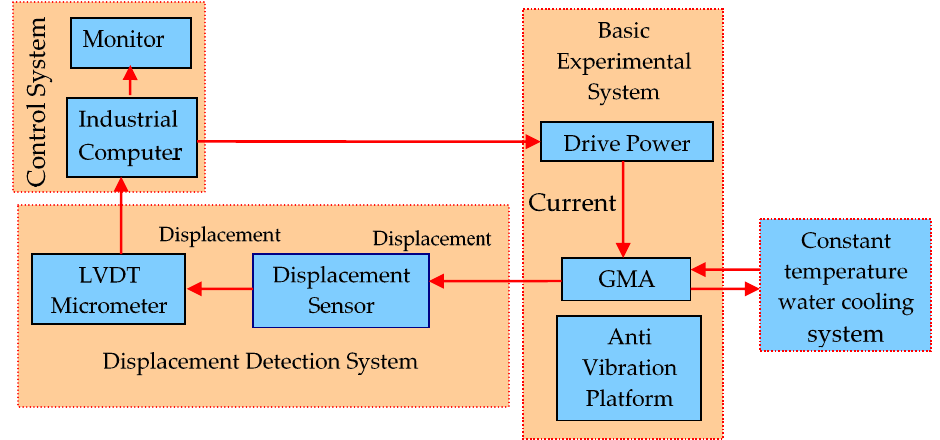
Figure 9. Overall experimental system platform. GMA—giant magnetostrictive actuator.